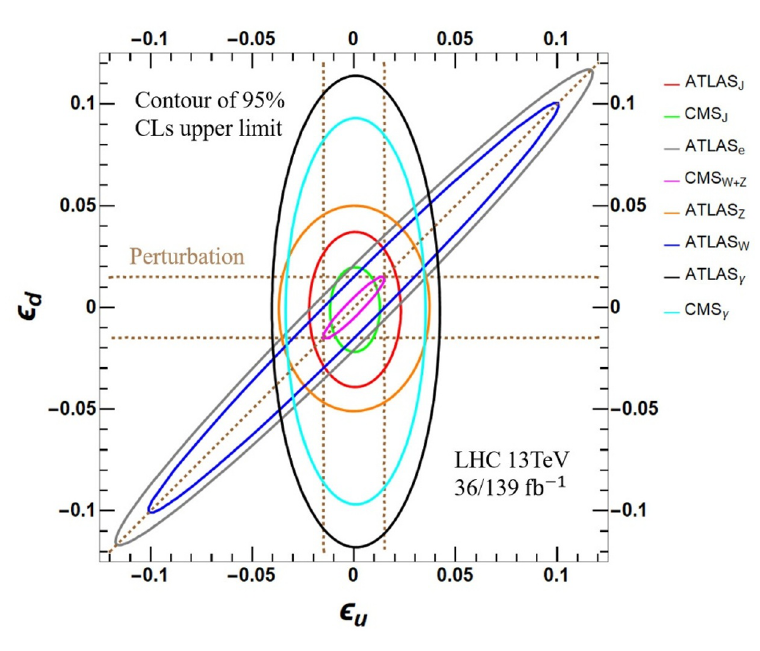
Figure 2. Contour of 95% CLs upper limit on the plane of NSIs (cid:15) u and (cid:15) d in the framework of effective operators with various measurements at the LHC. The vertical and horizontal dashed lines indicate bounds from perturbative